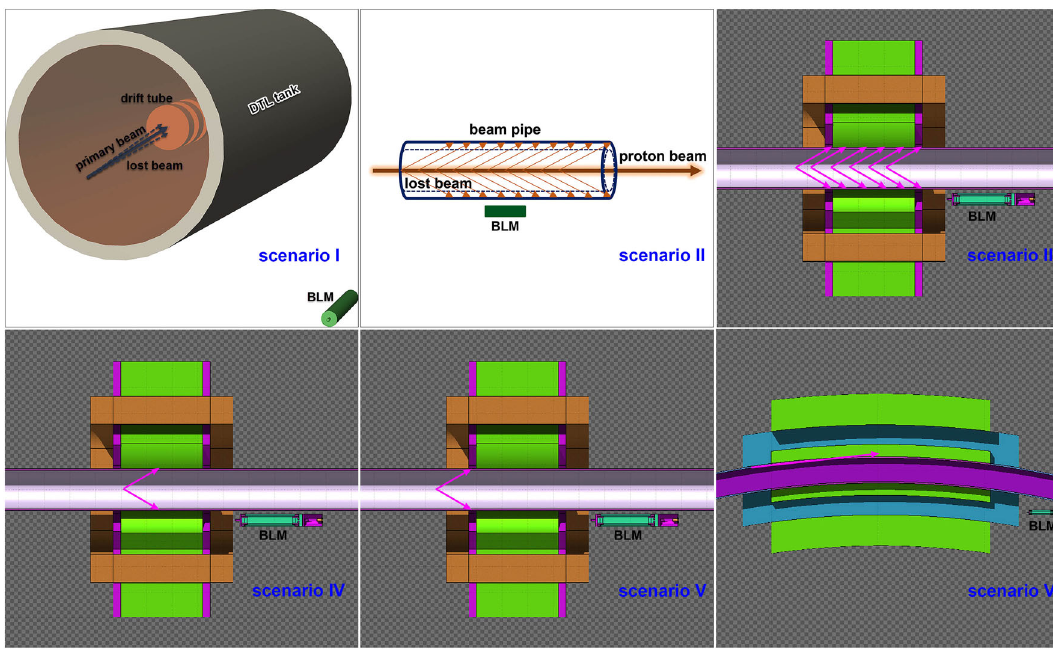
FIG. 17. Calculation models of the six assumed beam loss